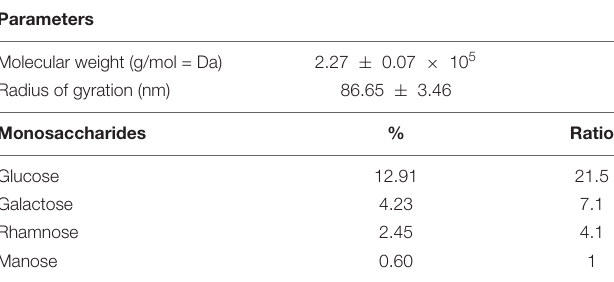
TABLE 3 | Physicochemical characteristics of